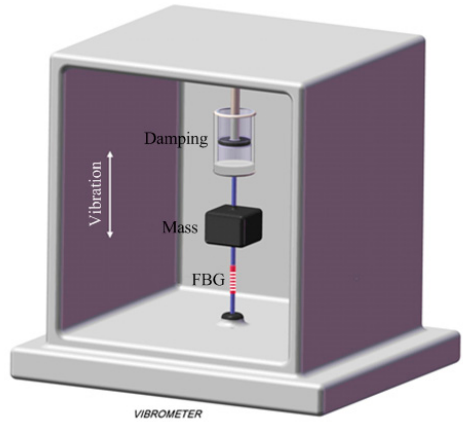
Figure2. Mechanical model of a FBG accelerometer.